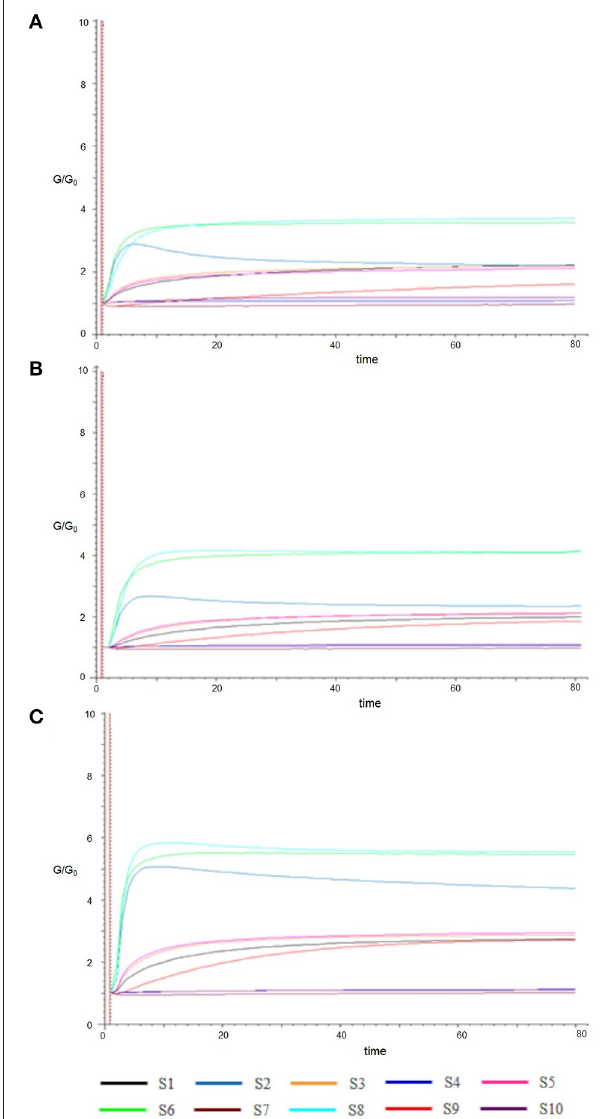
FIGURE 2 | Typical responses of sensors (S1–S10) to Fresh (A) and samples cold stored in Air (B) and High CO 2 (C) at 21 days.